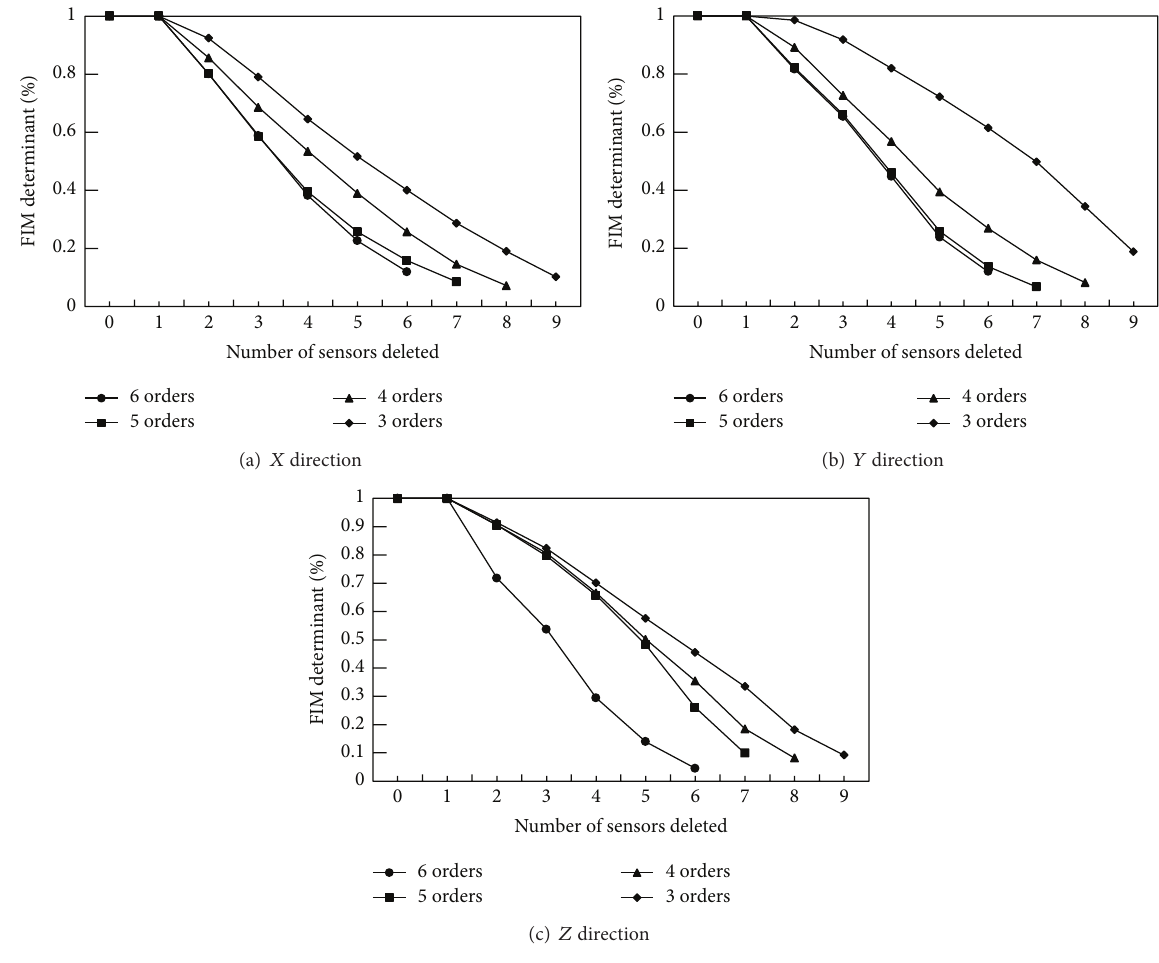
Figure 5: Fisher information matrix determinant. Table 4: Results of Fisher information matrix